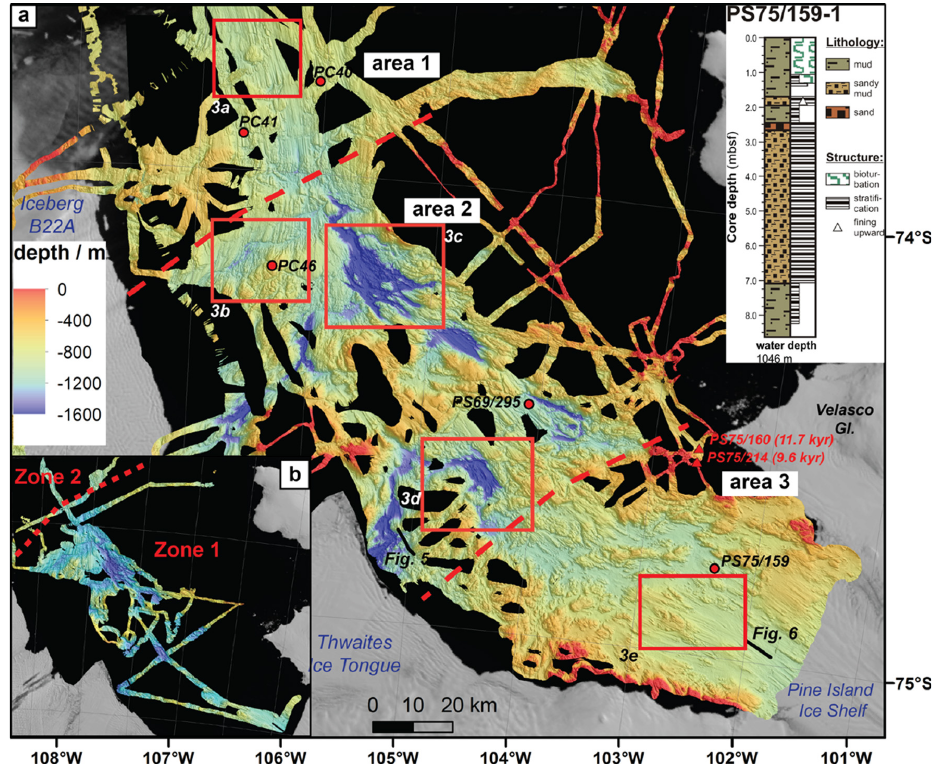
Fig. 2. (a) High-resolution bathymetry map of Pine Island Bay with artificial sun-illumination from the NE. Many of the larger gaps in the data set are due to icebergs at the time of data collection. Dashed red lines mark boundaries between morphological distinct areas 1 to 3. Red boxes mark detailed views shown in Fig. 3. Red dots mark sediment core locations. The inset in the upper right corner shows lithology of sediment core PS75/159. Background image is from the Landsat Image Mosaic of Antarctica (LIMA). (b) Multibeam bathymetry data from the same area published previously by Lowe and Anderson (2002, 2003). Red dotted line marks the boundary between the geomorphic zones 1 and 2 defined by Lowe and Anderson